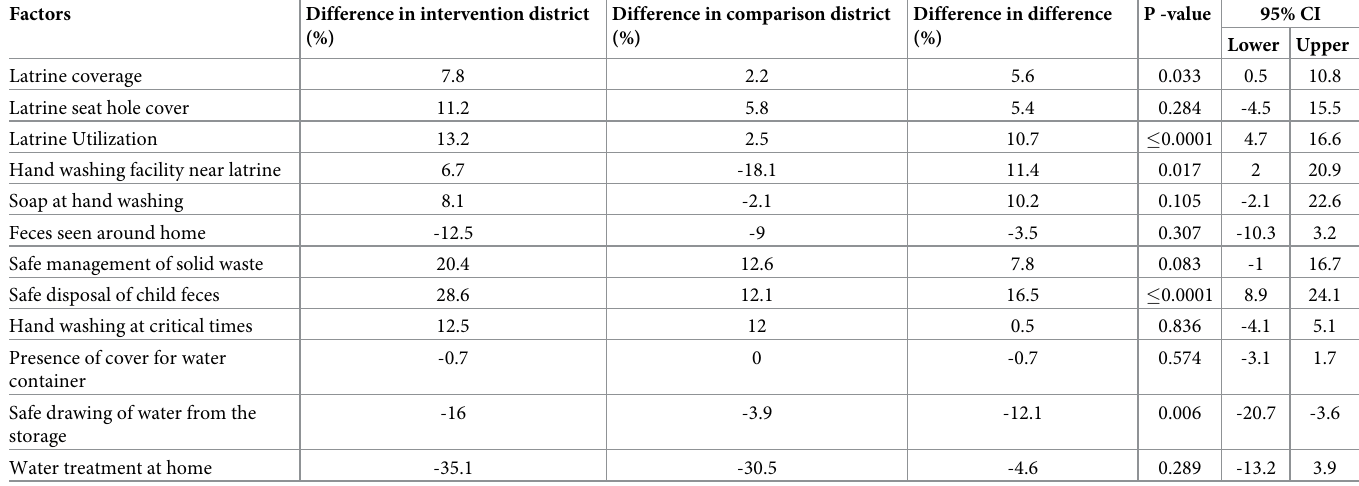
Table 4. Difference in difference of environmental and behavioral factors associated with diarrheal disease in intervention and comparison districts, Jimma zone, Oromia region, Ethiopia, 2019 (N = 836).